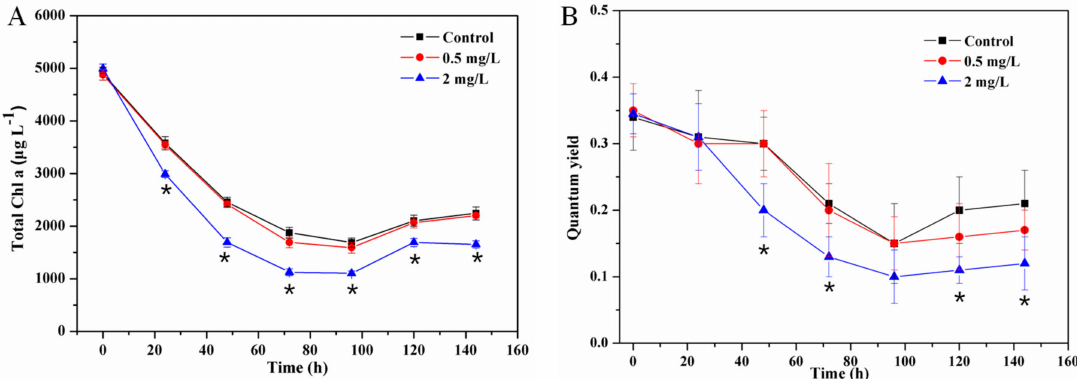
Figure 3. Dynamic changes of chlorophyll-a (Chla) ( A ) and quantum yield ( B ) in periphyton in di ff erent Cu treatments (0, 0.5 and 2 mg / L). * indicated significant di ff erences at p < 0.05 between the control and Cu 2 +